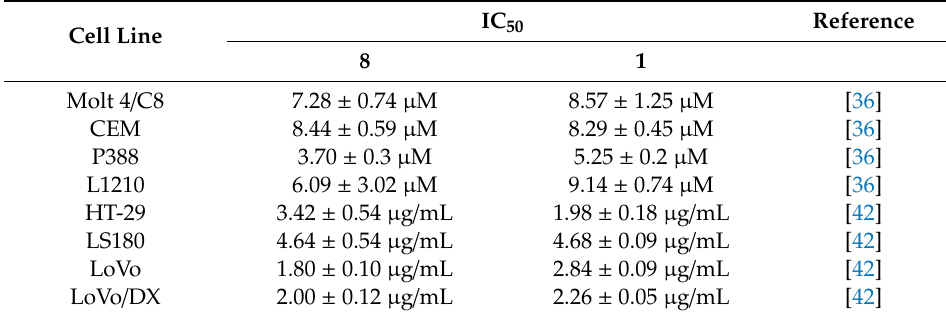
The cytotoxic activity for 8 was tested against many di ff erent cancer cell lines (Table 7). Table 7. Inhibitory e ff ect of compound 8 against the human Molt 4 / C8, CEM T-lymphocytes, murine P388, L1210, human colon cancer HT-29, LS180, LoVo, and LoVo / DX cell lines.